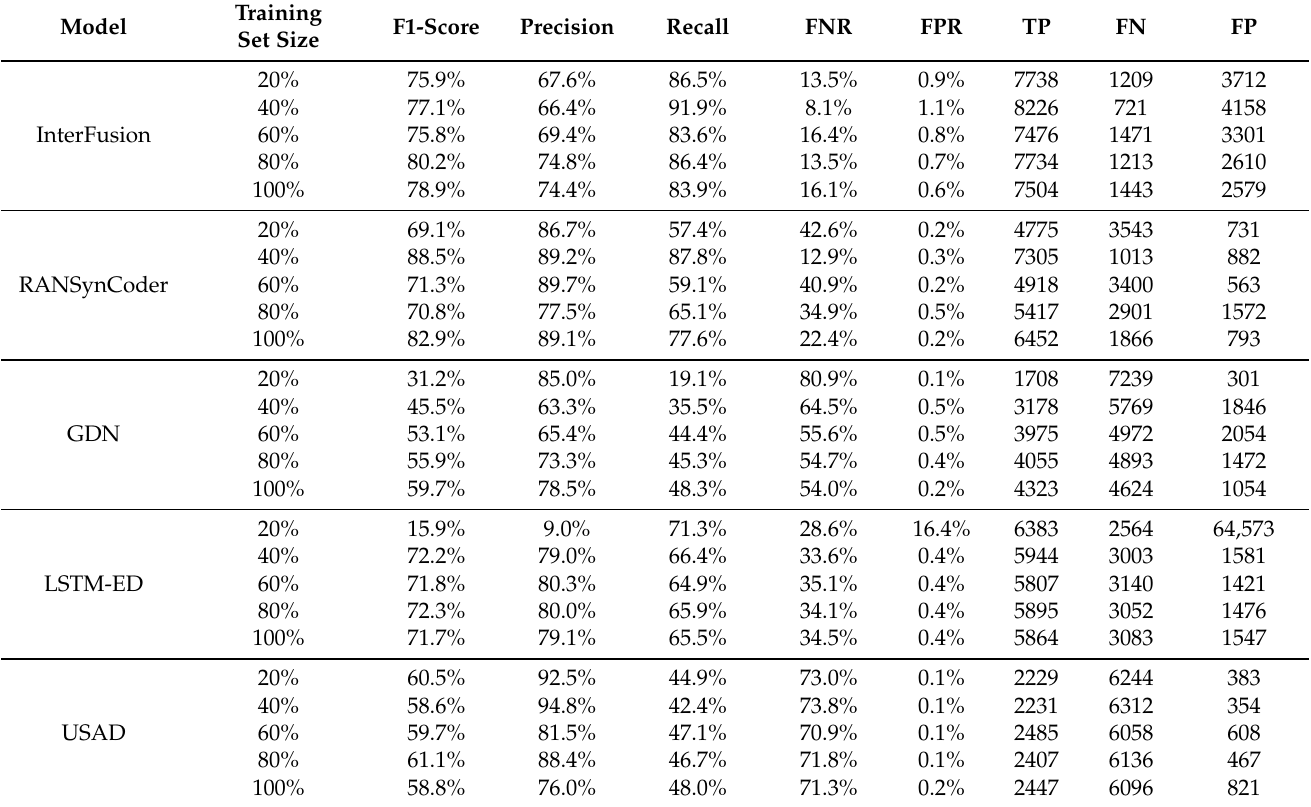
Table 9. Performance of anomaly detection models by varying the size of the training set in